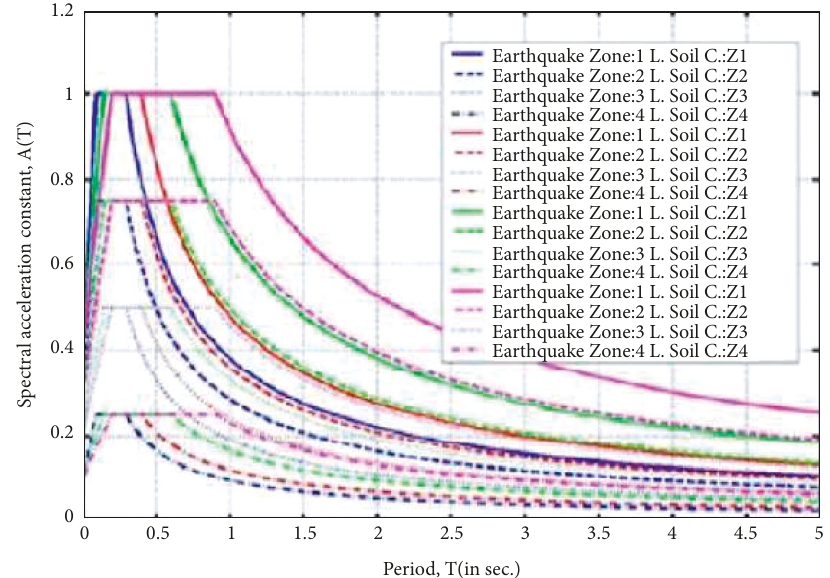
Figure 5: Elastic design acceleration spectra for four different earthquake zones and different local site classes [5].